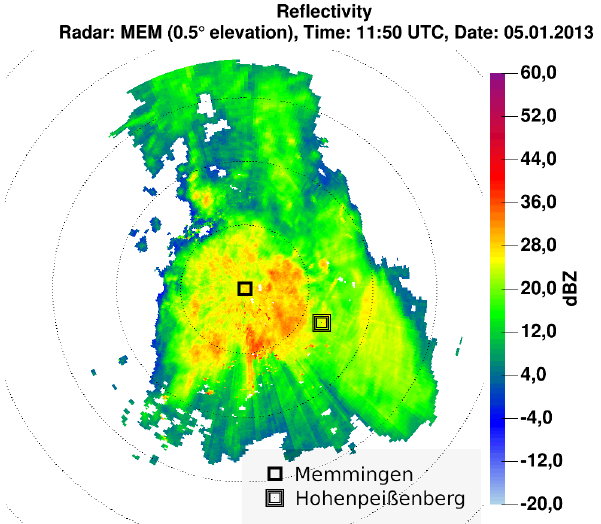
Figure 14. PPI of the hydrometeor classification at an elevation of 0.5 ◦ for the Memmingen radar at 11:50UTC. The location of Ho- henpeißenberg is